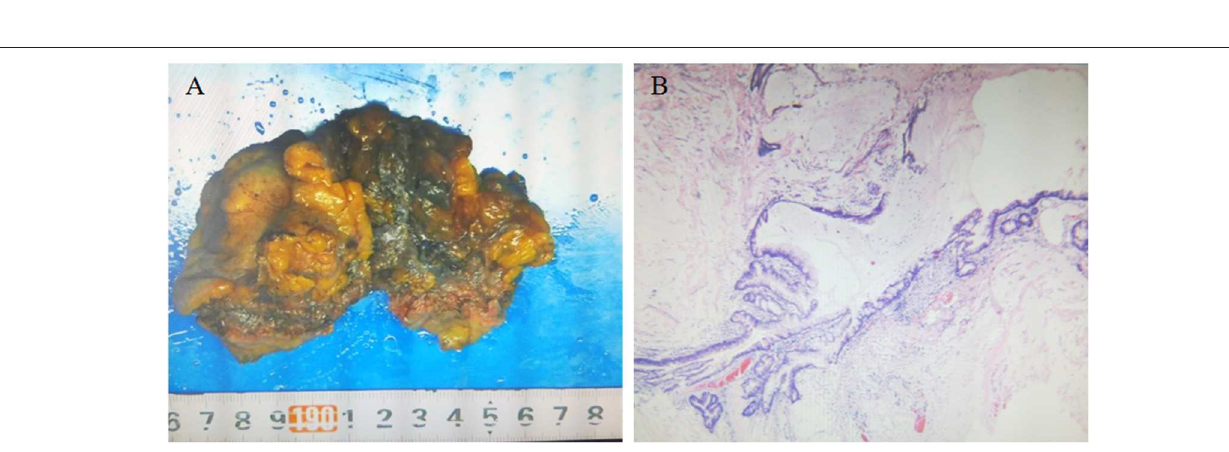
Frontiers in Oncology | www.frontiersin.org